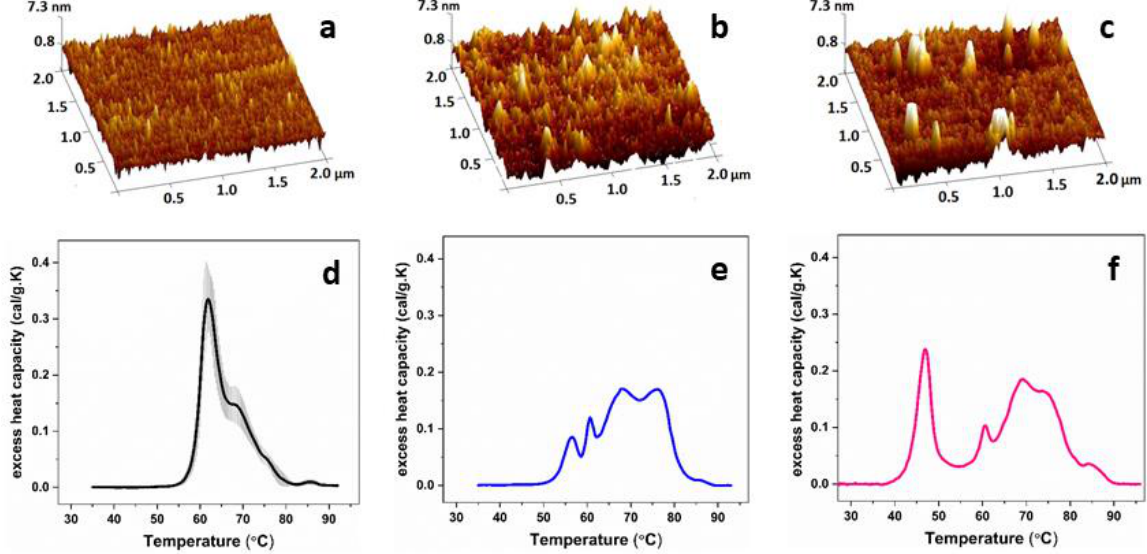
Figure 4. Atomic force microscopy images of blood serum of healthy control ( a ), a case from FLC2 calorimetric group (FLC concentration 10.5 ± 7.8% of the total protein content) ( b ) and a specific κ -FLC MM case (stage ISS III) with FLC concentration above 20% of the total protein content ( c ). The sera are deposited onto mica coverslip and measured in air. The white areas (with height above 4 nm) are due to amorphous aggregates). Calorimetric profiles of blood serum samples ( d – f ) corresponding to the AFM images in a–c, respectively. Modified from [39].